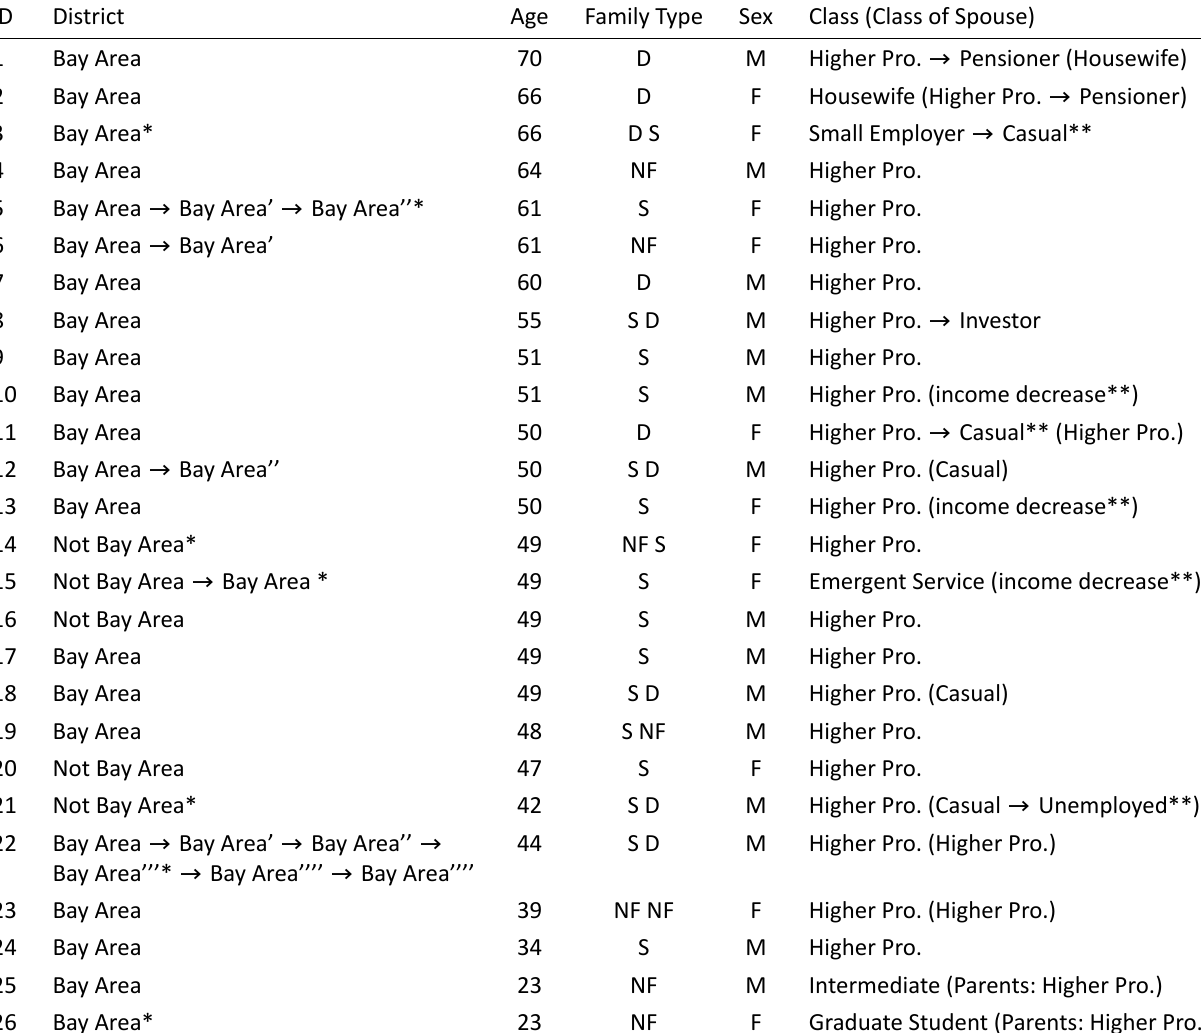
Table 1. List of